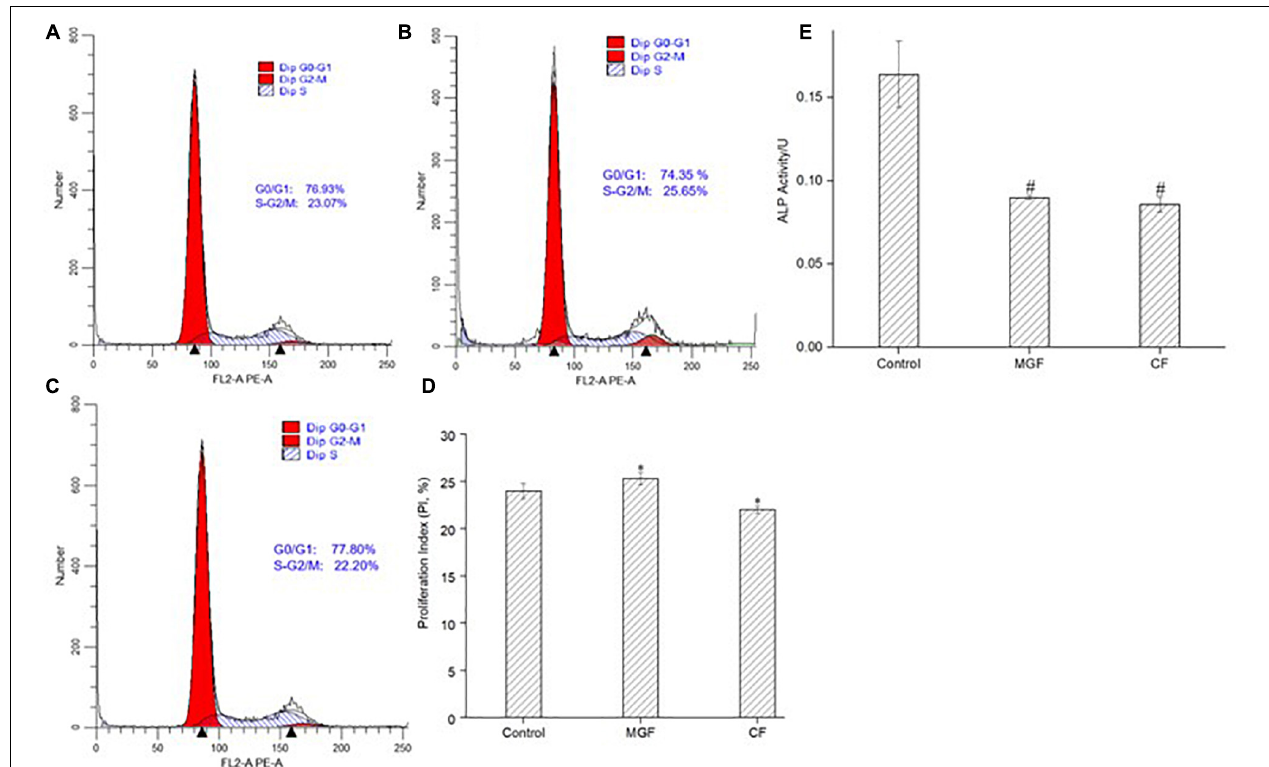
FIGURE 3 | Effect of peptide MGF and CF on MC3T3-E1 cells’ PI and ALP activity. (A) Control group. (B) Group treated with MGF for 72 h. (C) Group treated with CF for 72 h. (D) PI of MC3T3-E1 cells treated with MGF and CF. (E) ALP activity treated with MGF and CF for 120 h. ∗ P < 0.05, # P < 0.01.